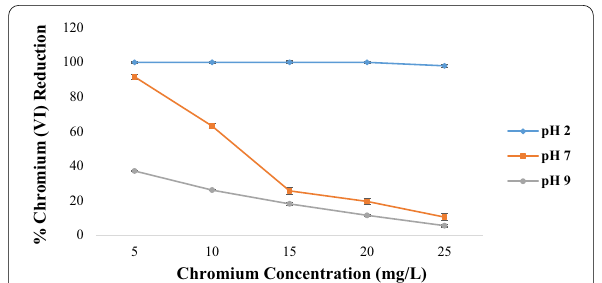
Fig. 3 Effect of initial chromium concentration on hexavalent chromium reduction by Tamarindus indica methanol leaves extract. (Extract concentration 1 mg/ml, time 30 min, = = temperature 27 °C, pH 2.0, 7.0 and 9.0) = =